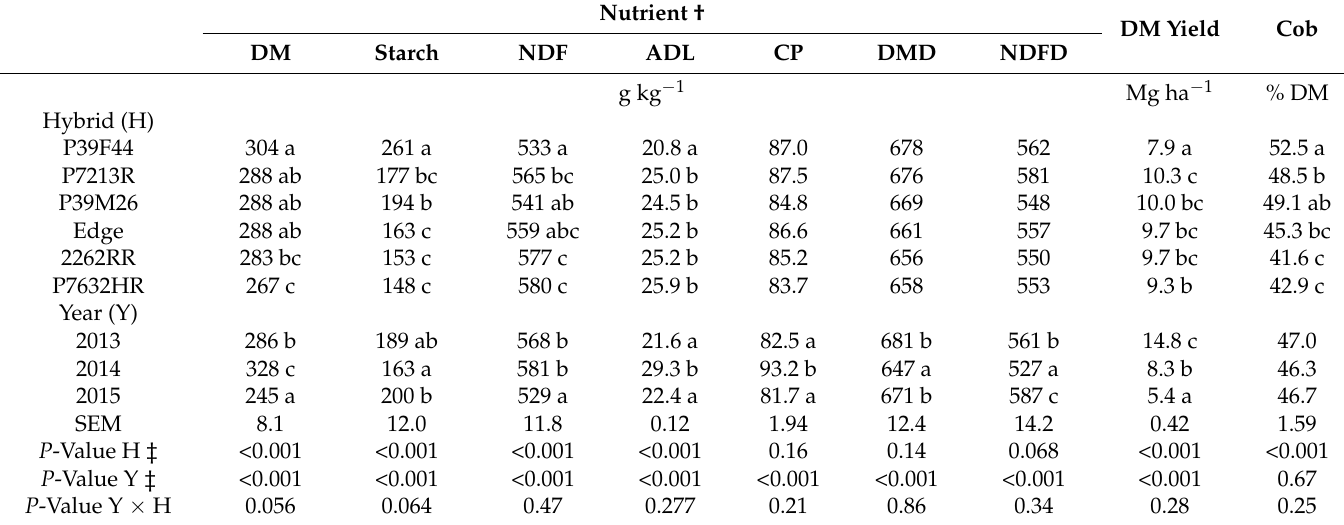
Table 5. Concentration of DM, starch, NDF, ADL, CP, DMD, NDFD, DM yield, and cob percentage for whole-plant corn grown at Lacombe (Alberta) over three